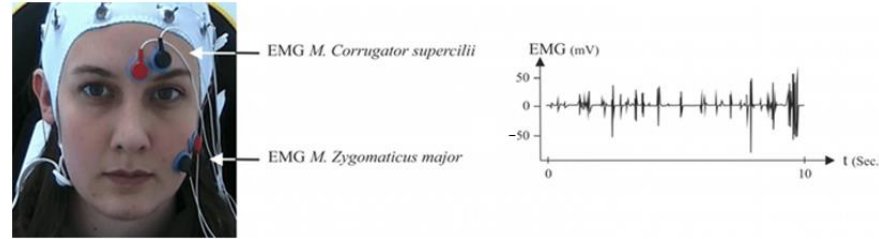
Figure 8. Placement of fEMG electrodes and a sample of a filtered EMG signal [319].